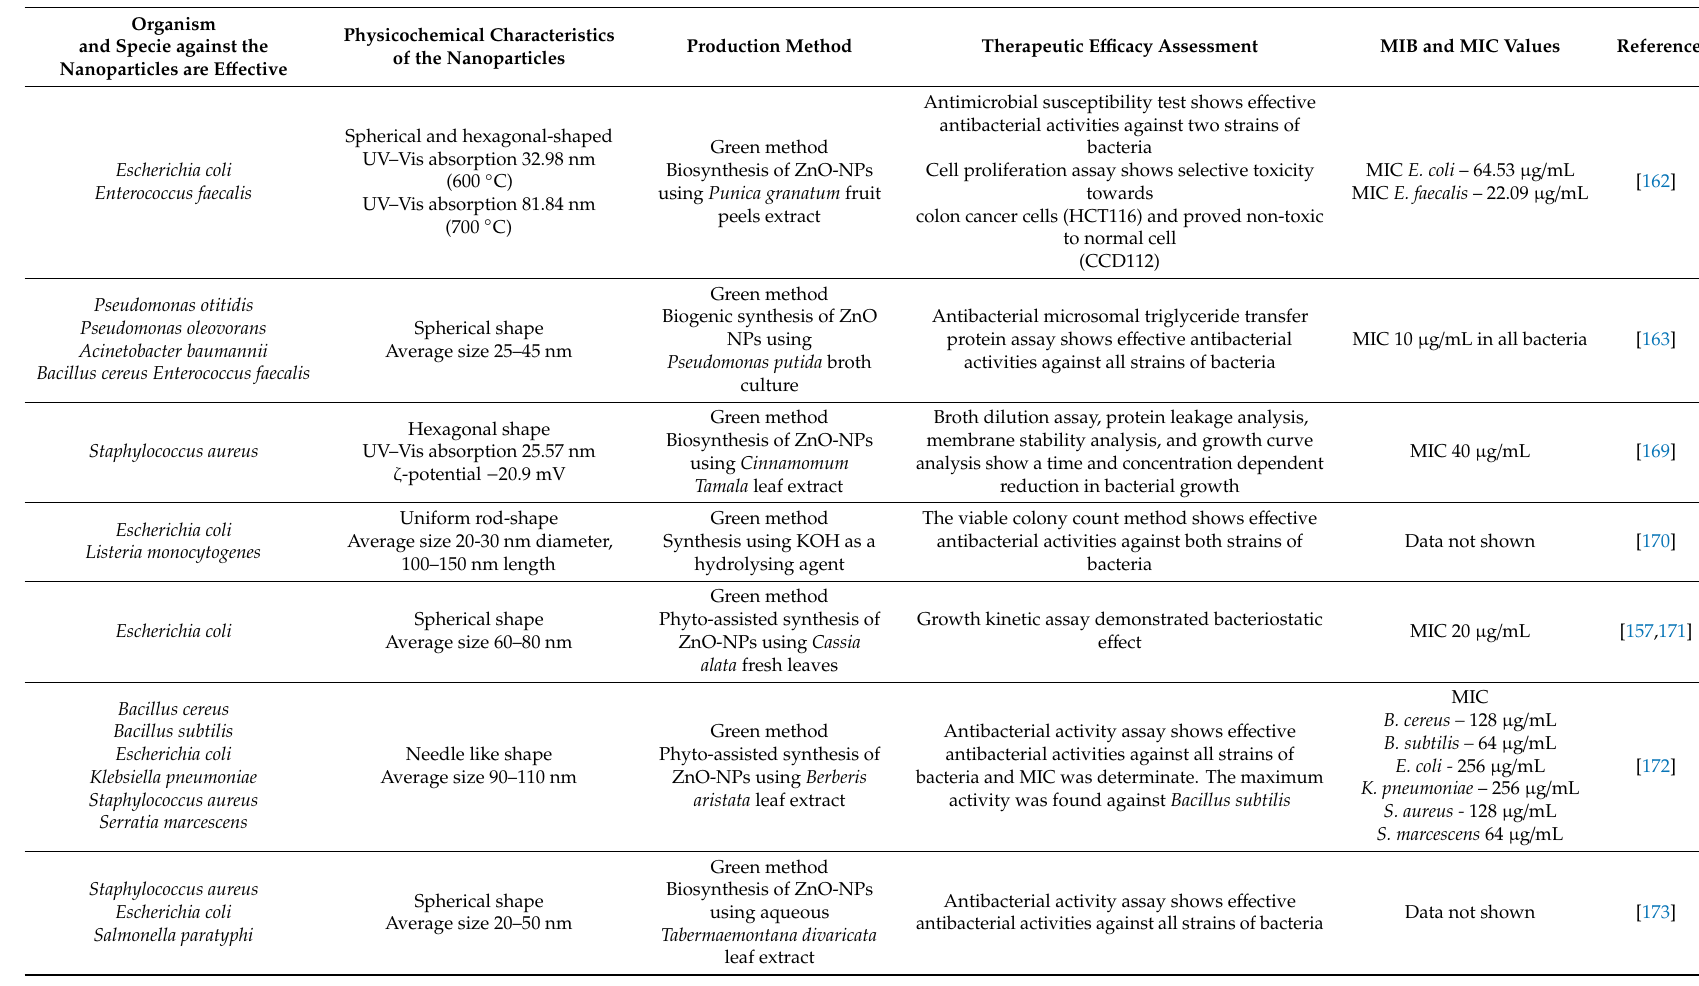
Table 5. Antibacterial applications of zinc oxide nanoparticles, with respective mminimum inhibitory concentration (MIC) and minimum bactericidal concentration (MBC)